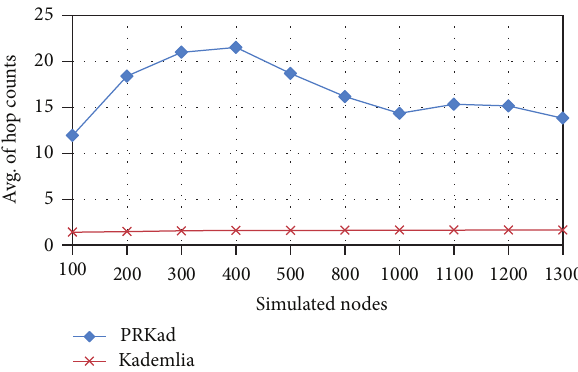
Figure 8: Average of hop counts for successful searches.